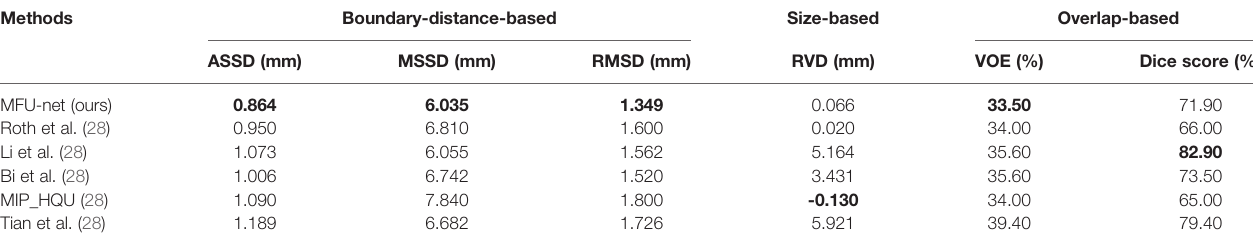
The bold values are the best (state-of-the-art)